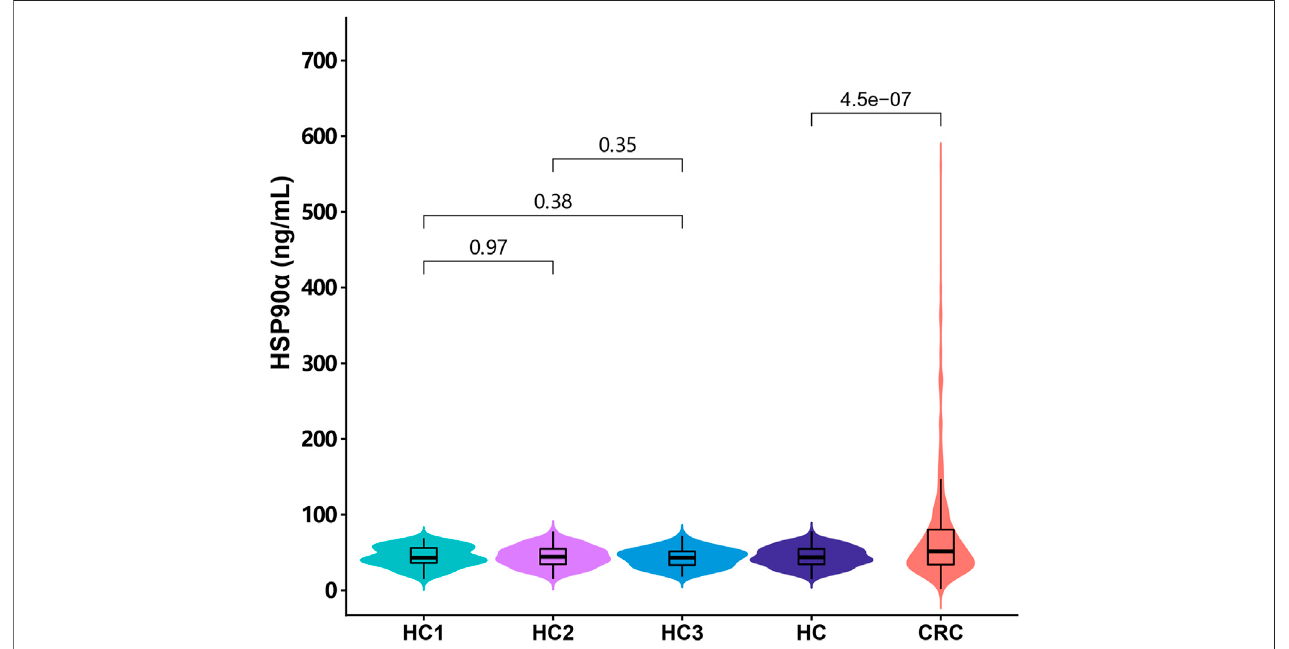
FIGURE 1 | The distribution of the plasma HSP90 α protein expression in colorectal cancer patients and healthy controls. HC1: subgroup under 40 years of age in healthycontrolgroup;HC2:subgroupofhealthycontrolsaged40 – 59years;HC3:subgroupover60yearsofageinhealthycontrolgroup;HC:allhealthycontrols,CRC: colorectal cancer.